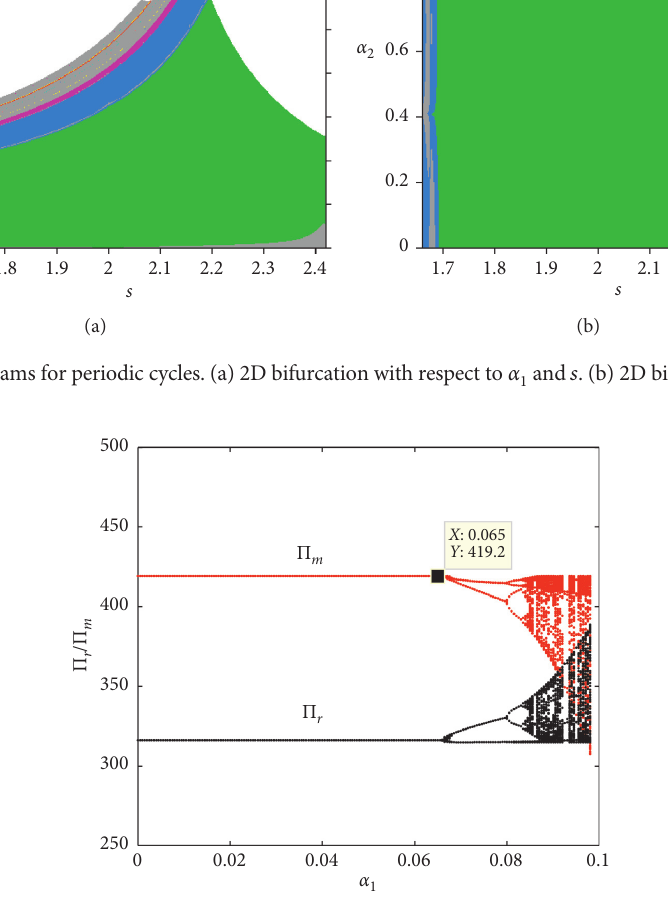
􏽑 r and m with respect to α 1 as α 2